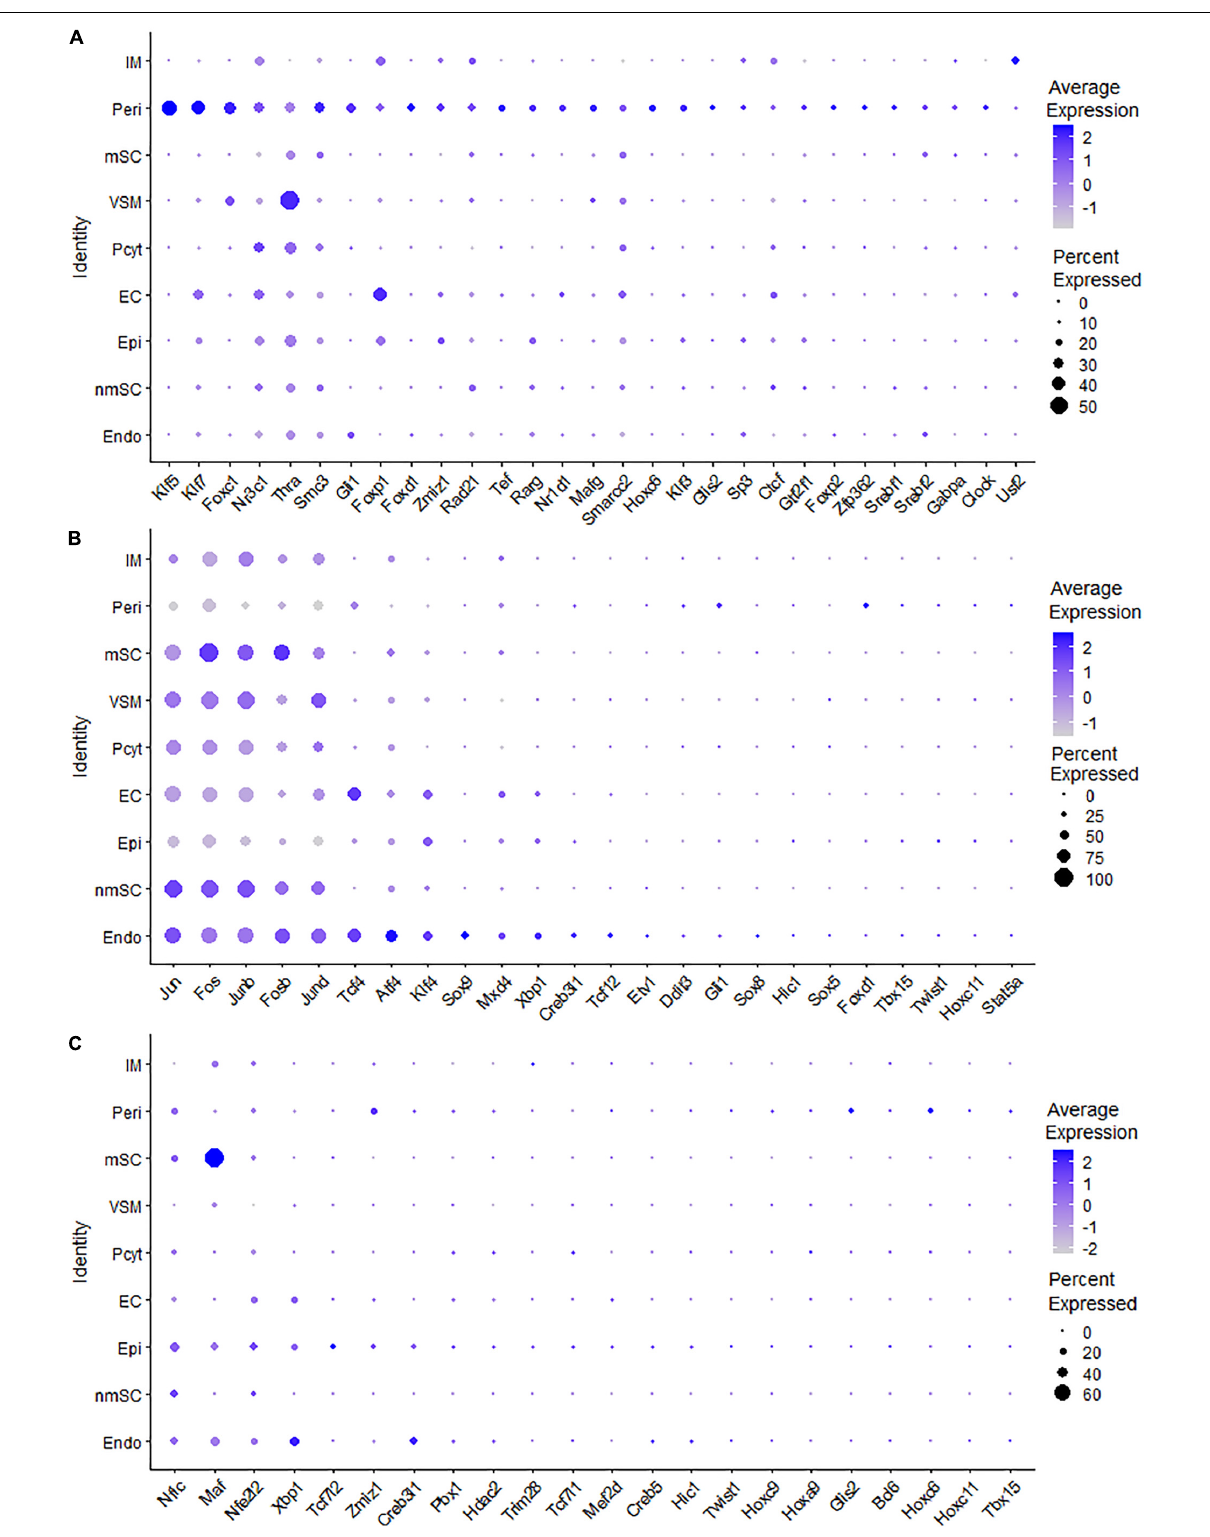
Frontiers in Cellular Neuroscience |